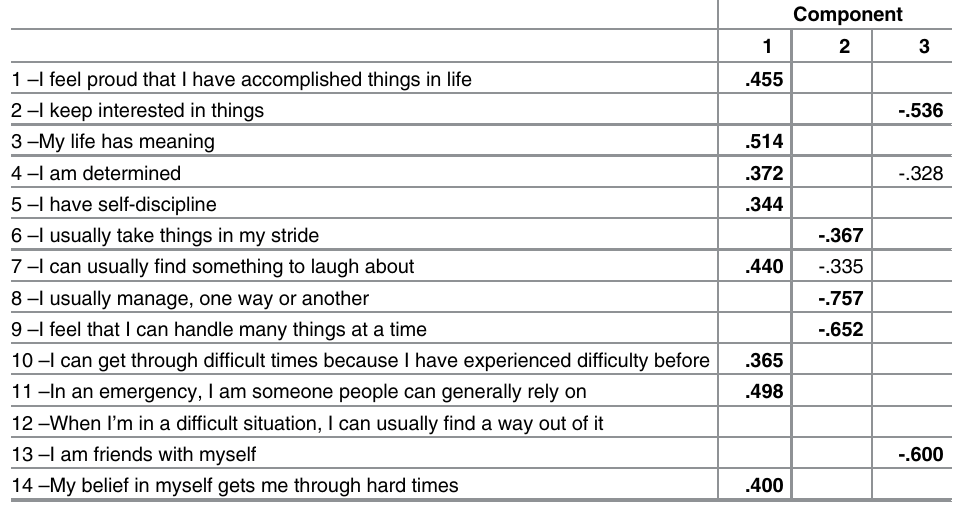
Table 3. Principle Axis Factoring (with Direct Oblimin Rotation) of the 14 RS-14